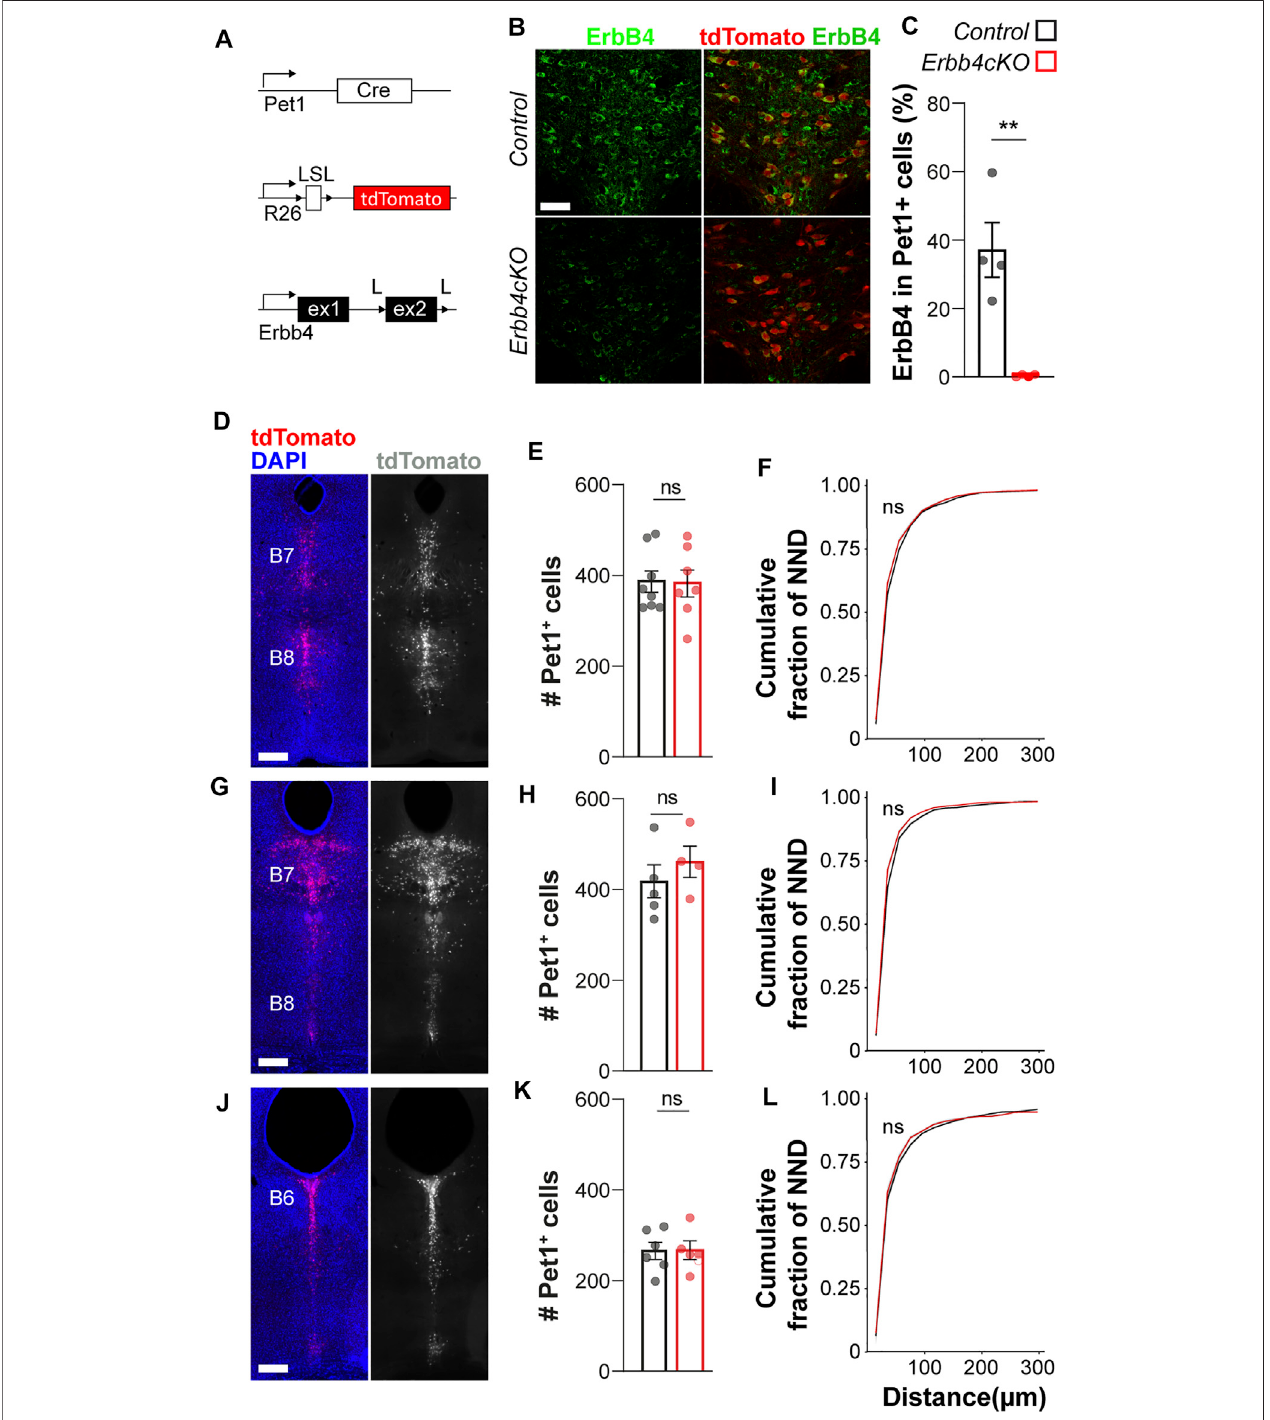
FIGURE 2 | ErbB4 isnot required for Pet1 + serotonergic neuronalmigration. (A) Genetic strategy to generate Erbb4cKO mice. L: loxP, LSL: loxP-STOP-loxP site. (B) Confocalimages ofErbB4-expressing and Pet1 -driventdTomato-expressingneurons inthe dorsal rapheofcontrol and Erbb4cKO mice.( n (cid:2) 4brains in controland n (cid:2) 4 in Erbb4cKO mice from 3 different litters) (C) Quanti fi cation of percentage of colocalization of ErbB4+ and tdTomato+ neurons shows a signi fi cant reduction of colocalizing cells in Erbb4cKO mice when compared to control mice. (D – L) Distribution of Pet1 -tdtomato+ neurons in the dorsal raphe nucleus (DRN). Coronal brain sections showing distribution of tdTomato+ neurons assessed at different levels of the DRN: Bregma − 4.48 mm and (D) Bregma − 4.72 mm (G) corresponding to B7/B8nucleiaswellasBregma − 5.02 mm (J) correspondingtoB6. (E,H,K) Quanti fi cationoftotaltdTomato+neuronsfoundateachcoordinateasdepictedin (D,G,J) intheDRNofcontroland Erbb4cKO miceshowsnon-signi fi cantdifferences( n (cid:2) 5 – 8controland n (cid:2) 4 – 7mutantbrainsfrom3differentlitters). (F,I,L) Cumulativefraction ofNNDsmeasured ateach coordinate intheDRNshowsnon-signi fi cantdifferencesincelldistribution( n (cid:2) 5 – 8controland n (cid:2) 4 – 7mutant brains from3differentlitters). Scale bars in (B) : 50 µm and in (D, G, J) : 500 µm. Data are represented as mean ± SEM. ns: not signi fi cant differences; **: p < 0.01. t-test or Kolmogorov-Smirnov test.